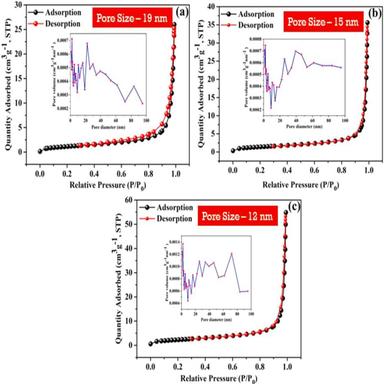
BET analysis of (a) NiCoP (b) NiCoP/WSe2 (c) NiCoP/WSe2@ZnS.